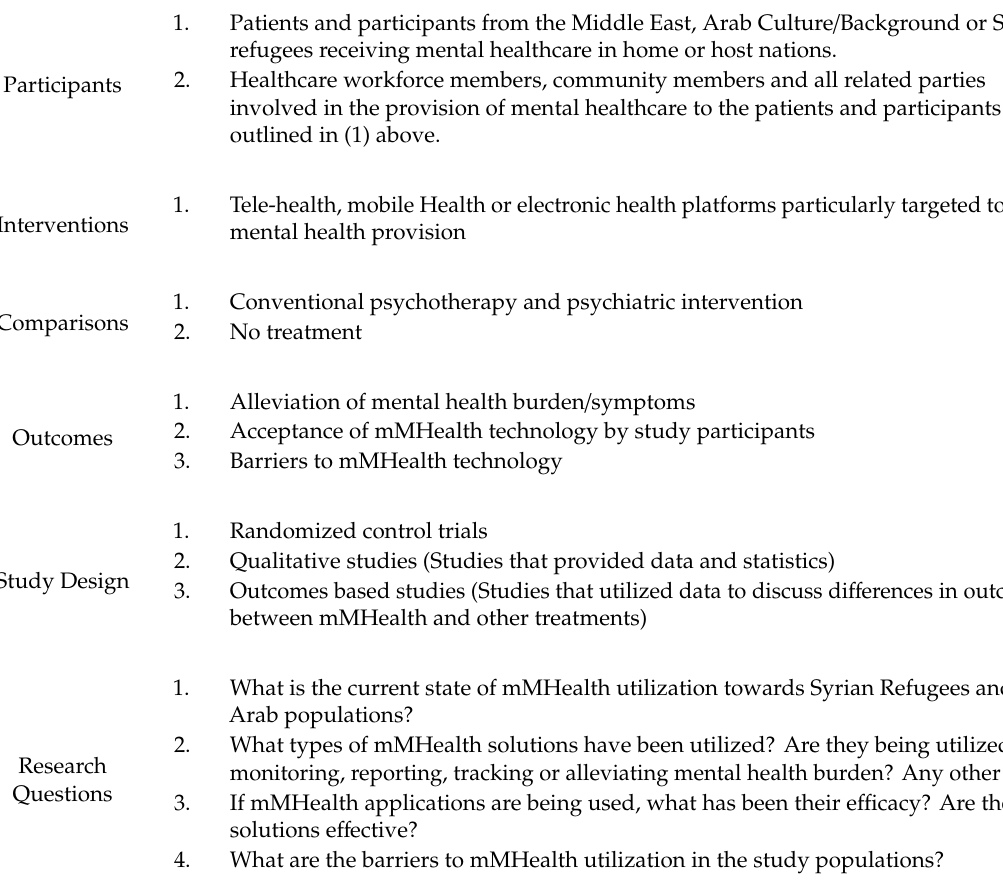
Table 1. PICOS * Outline & Research